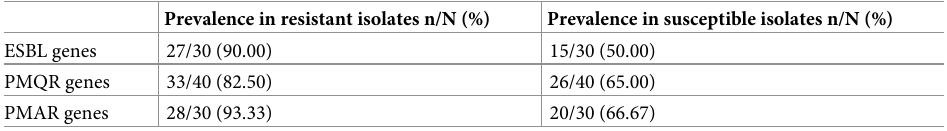
Table 7. Prevalence of resistance genes in resistant and susceptible